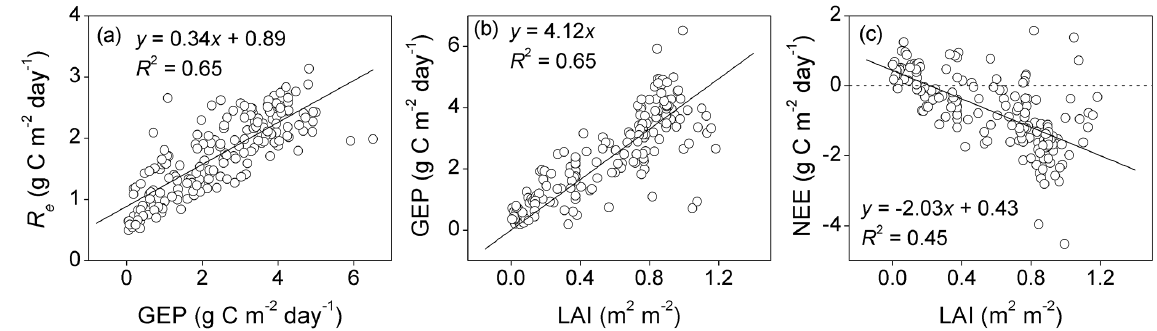
Figure 8. Relationship between gross ecosystem productivity (GEP) and ecosystem respiration ( R e ) (a) , and between leaf area index (LAI) and GEP (b) and net ecosystem CO 2 exchange (NEE) (c) . Daily values are shown for the growing period when LAI >0. The horizontal dashed line in (c) represents y =